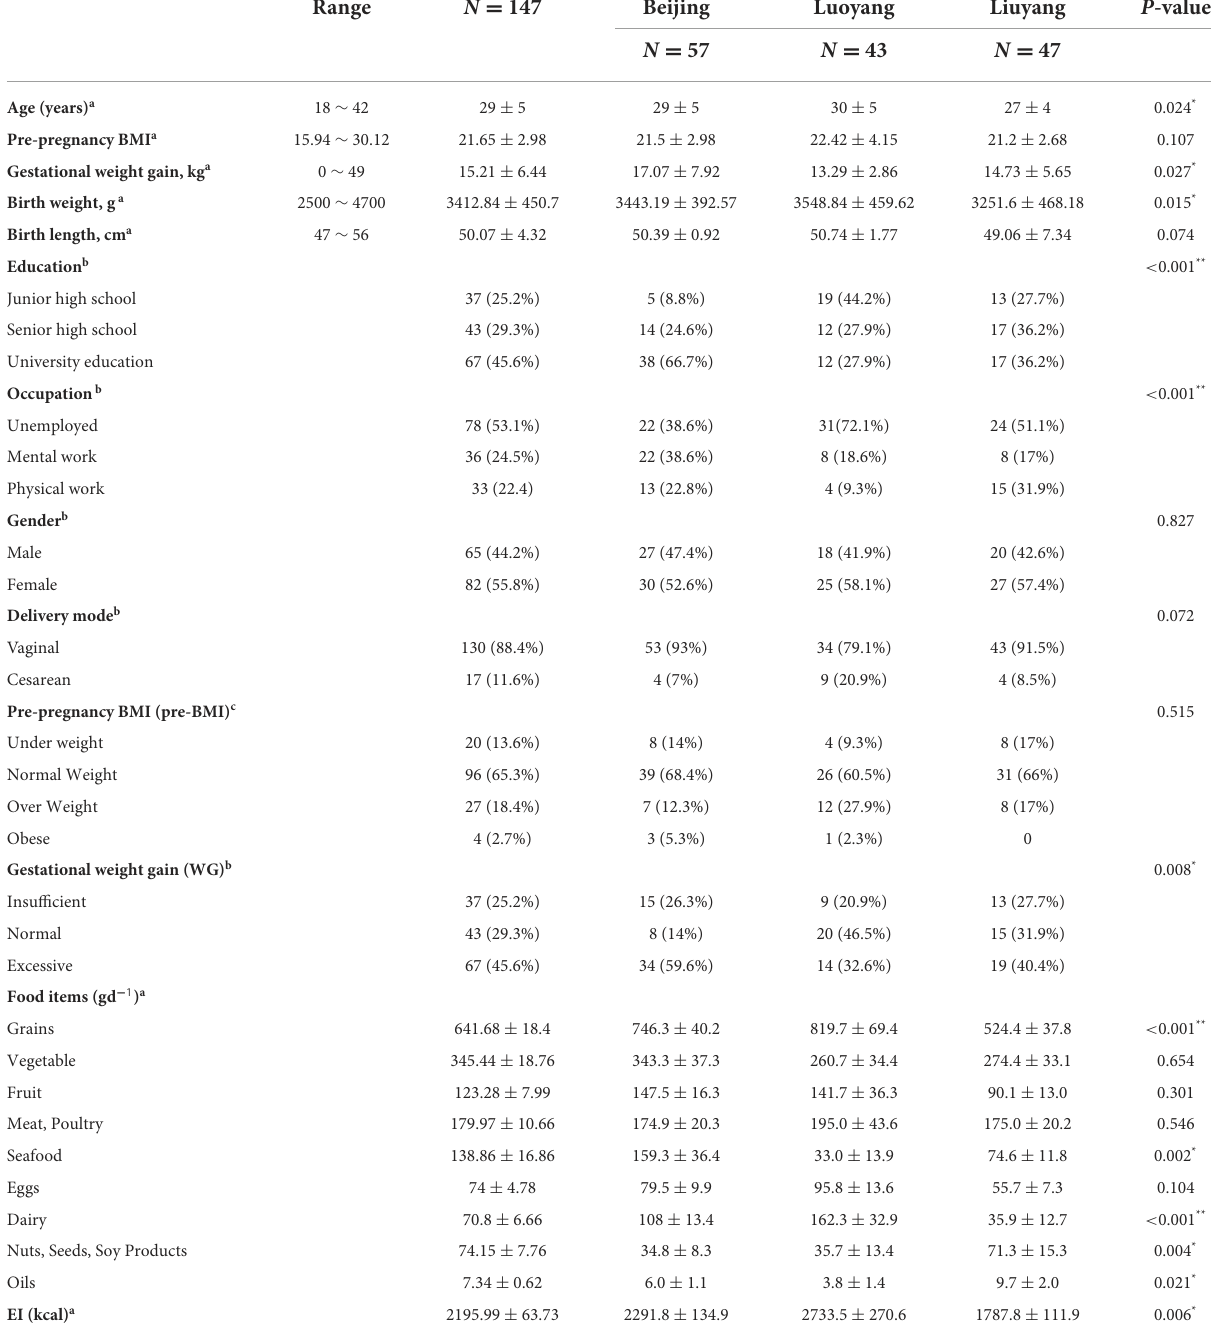
TABLE 1 Characteristics of the 147 mother-infant pairs and maternal daily dietary intake in China. Range N =